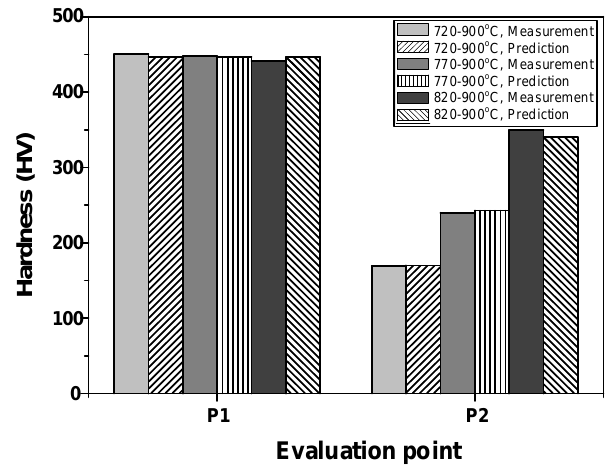
Figure 15. Comparison of the hardness between the measurement and prediction for the low- and high-strength regions.